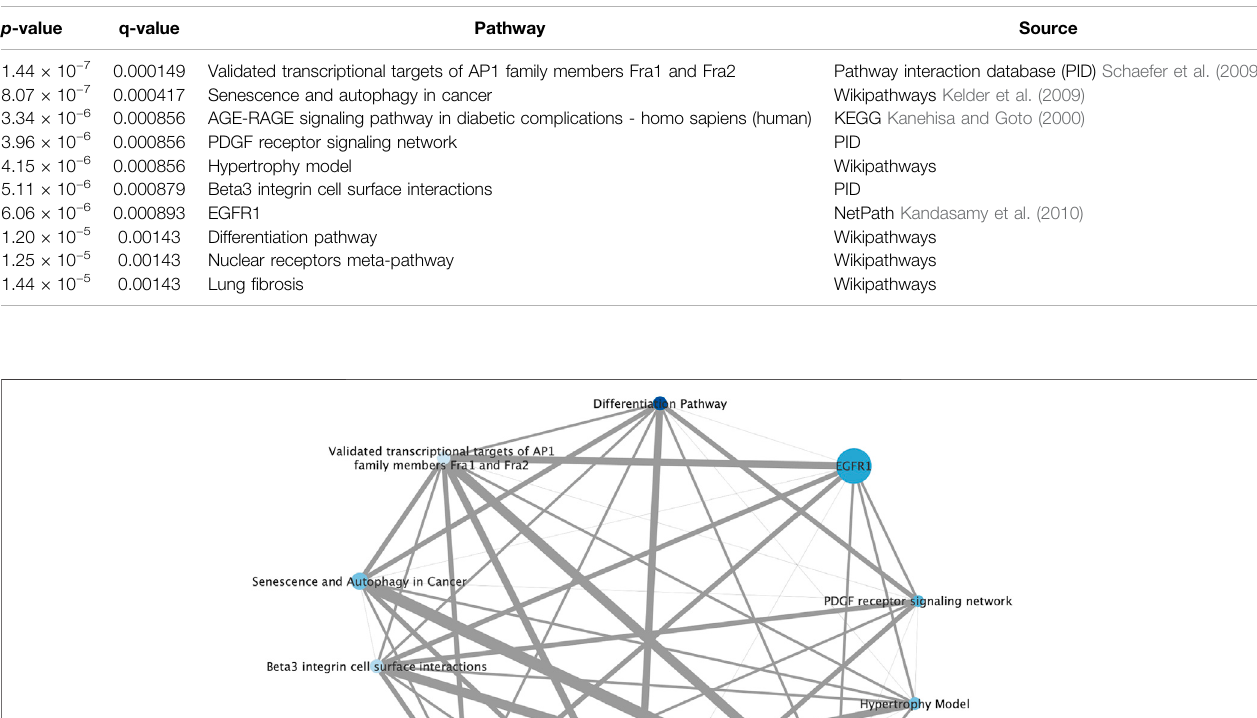
con fi rm that mRNA expression of CXCL8, CYR61 , FGF16 and